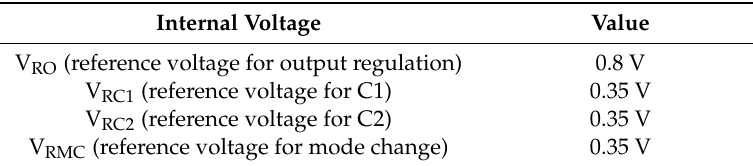
Figure 9. The proposed energy management integrated circuit (EMIC) block diagram. Table 2. Internal voltage values in the proposed EMIC.